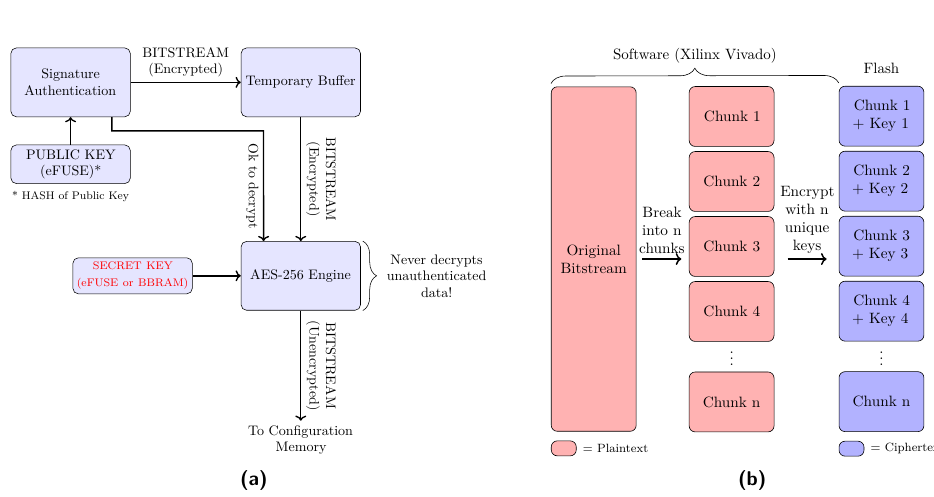
Figure 1: SCA countermeasures of the of the Xilinx ZU+: (a) asymmetric authentication of the configuration data (bitstream), (b) key